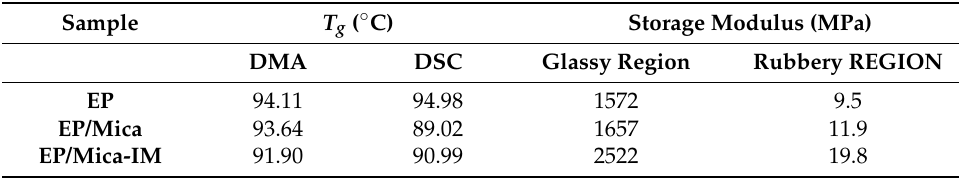
Table 4. Values of T g of completely cured samples collected at β of 10 ◦ C min − 1